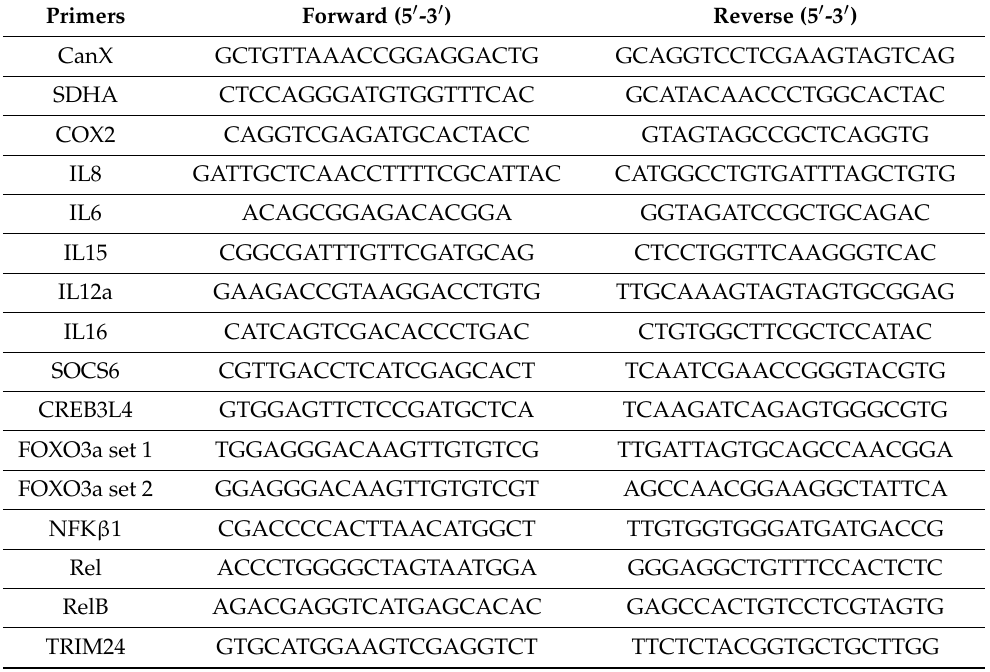
Table 1. Primers used in this